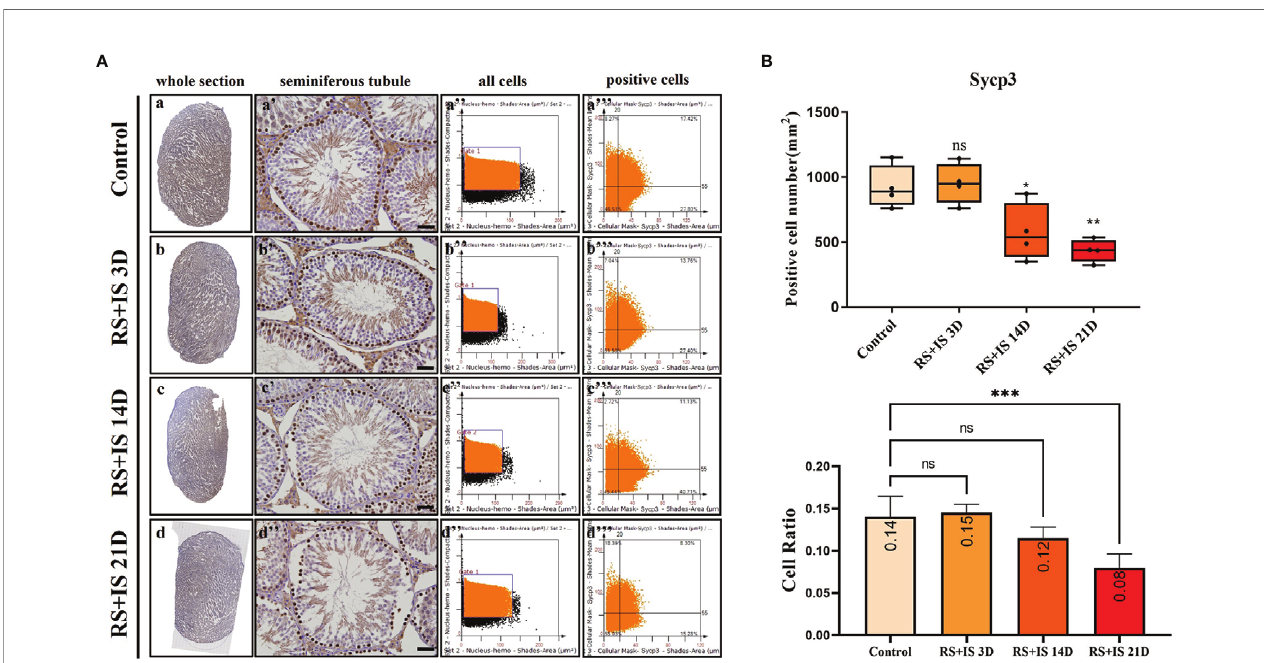
FIGURE 6 | (A) IHC expression of Sycp3. (a – d) show the section of testis. (a ’– d ’ ) show the seminiferous tubule (Bars = 50 m m). (a ’’– d ’’ ) positive points represent all cells. (a ’’’– d ’’’ ) all the positive points in the right upper quadrant represent the positive cells. (B) Box plot shows Sycp3 (upper)-positive cell counting number; each point represents one section. Bar plot (lower) shows Sycp3-positive cell ratio (positive cell counting/all cell counting), n = 4. Values with different superscripts indicate signi fi cant differences between control and treatment groups on one-way ANOVA (* P < 0.05, ** P < 0.01, *** P < 0.001). ns, non-signi fi